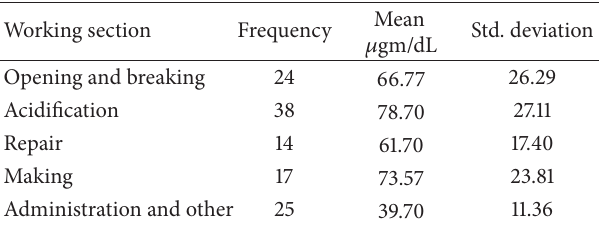
Table 1: Blood lead level of respondents according to working